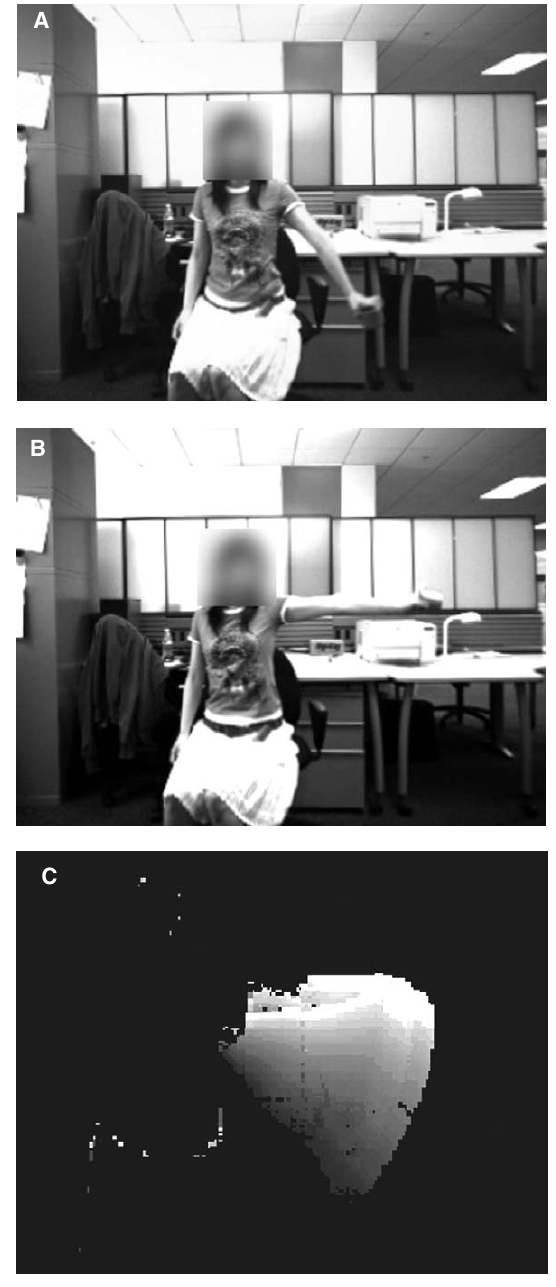
Fig.1. MotionHistoryImageoftheleftarmmovement.(a)Subject’s startingposition.(b)Subject’sendingposition.(c)MHIofsequence. Utilizing the feature vectors of the reference